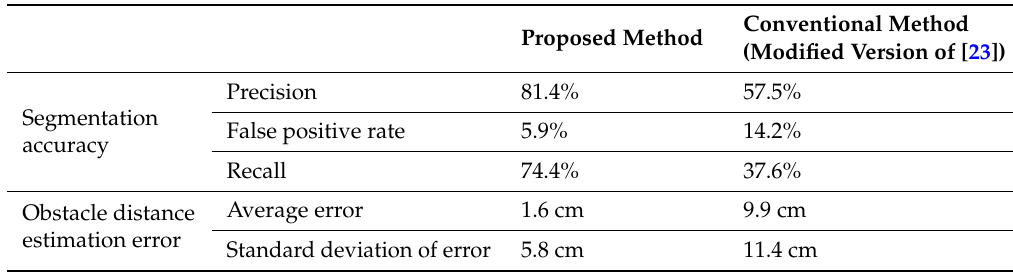
Table 1. Segmentation accuracy and obstacle distance estimation error for obstacle datasets.